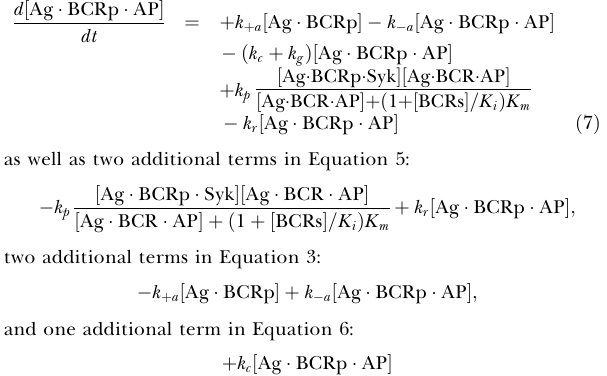
Figure S2. Sensitivity of Model Results to Parameter Values Variation in the (A) height and (B) time of the peak in phosphor- ylation as rate constants indicated were varied from 0.1 to 100 min (cid:1) 1 with the remainder fixed at their values (given in the legend to Figure 6 in the main text). The ratios k p / k r , k þ a / k –a , k þ s / k –s , and k on / k off were held